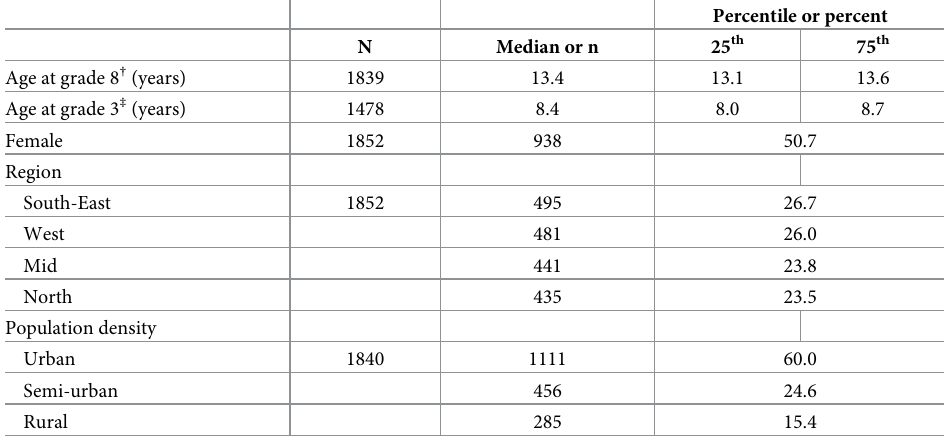
Rural 15.4 N, max number that the information was derived from as included in the longitudinal analysis. � Data shown in n (%) unless otherwise stated.